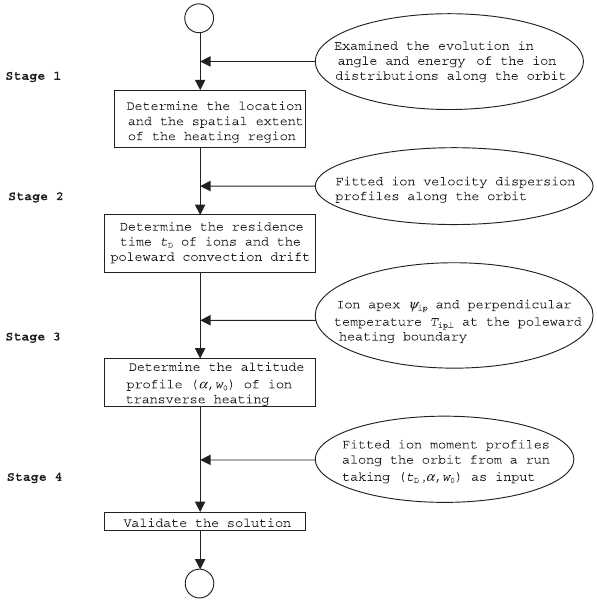
Fig. 4. Flow chart of the procedure applied to determine the param- eters associated with transverse heating and the horizontal